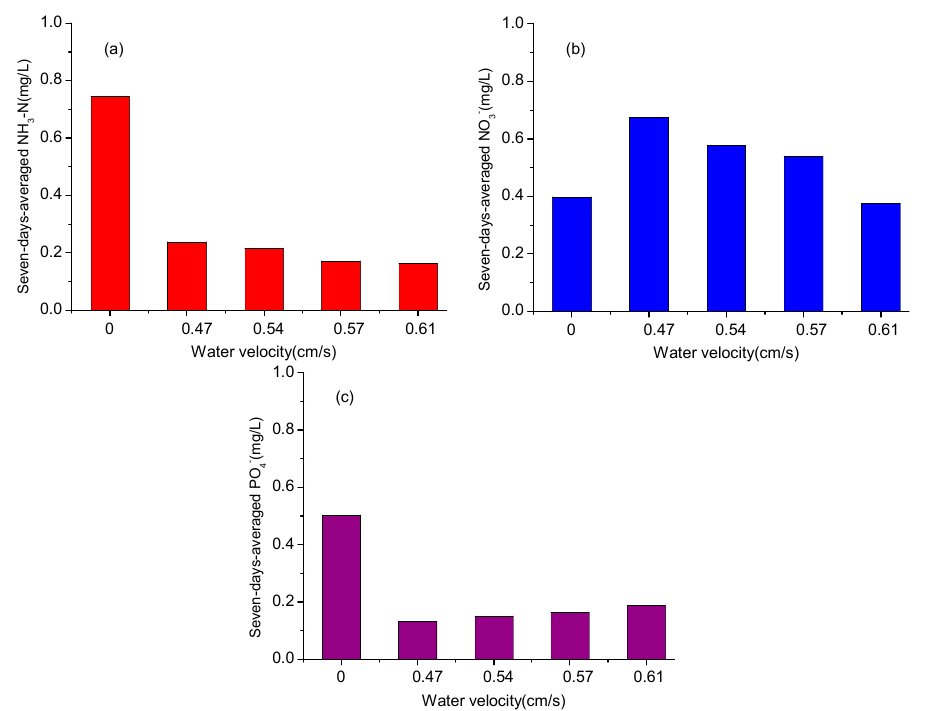
Figure 10. The seven ‐ day ‐ averaged concentrations in the overlying water for: ( a ) NH 3 ‐ N, ( b ) NO 3 ‐ N and ( c ) PO 4 − . and ( c ) PO − 4